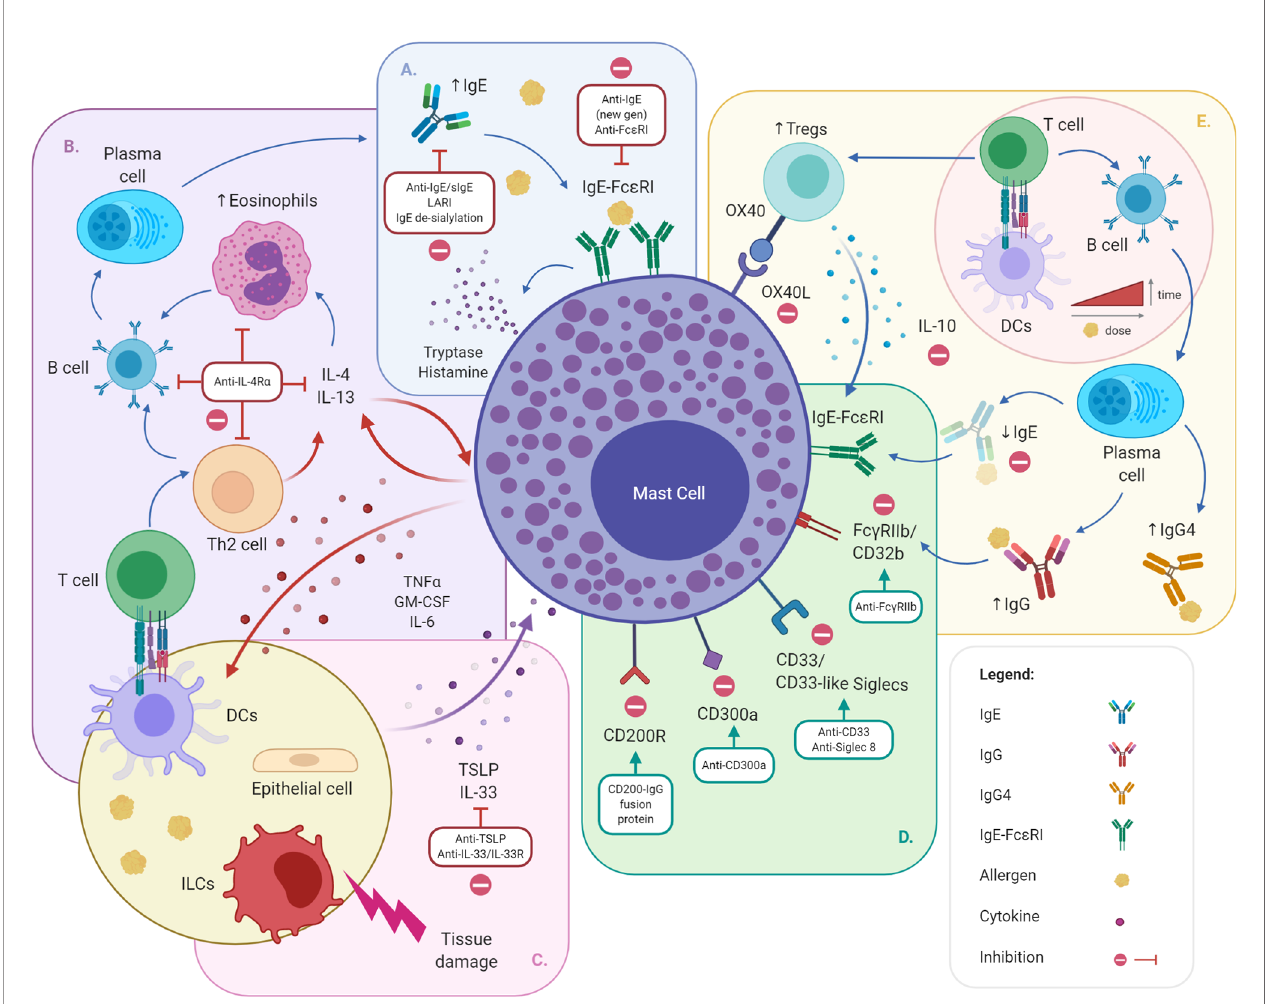
FIGURE 1 | Approaches to target mast cell-dependent allergic responses. Summary of mechanisms controlling MC activation and degranulation and targeted inhibitory approaches, namely suppression of the IgE/Fc ϵ RI axis (A) , modulation of IL-4/IL-13 (B) and IL-33/TSLP (C) cytokines, engagement of MC inhibitory receptors (D) and allergen immunotherapy (E) . DCs, dendritic cells; Fc ϵ RI, high-af fi nity IgE receptor; Fc g RIIb, low af fi nity IgG receptor b; IgE, immunoglobulin E; IgG, immunoglobulin G; IgG4, immunoglobulin G 4; IL-4R a , interleukin 4 receptor alpha chain; LARI, low af fi nity allergic response inhibitors; MC, mast cell; Siglec, Sialic acid-binding immunoglobulin-type lectins; Tregs, T regulatory cells; TSLP, Thymic stromal lymphopoietin. Created with